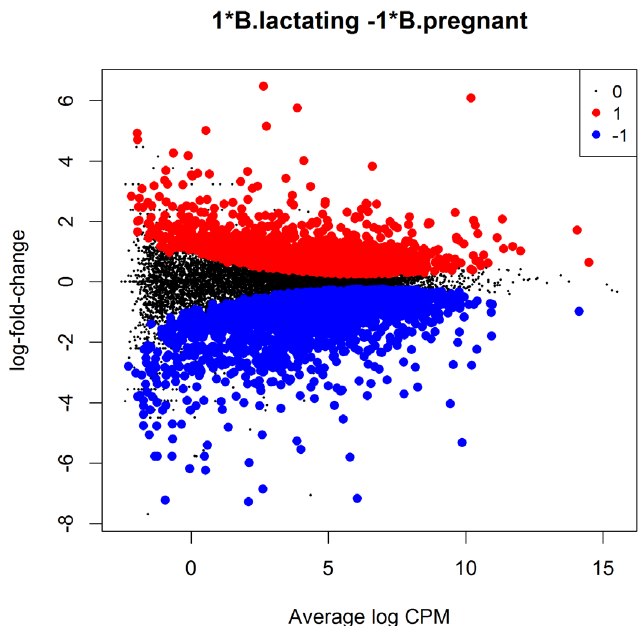
Figure 6. MD plot showing the log-fold change and average abundance of each gene. Significantly up and down DE genes are highlighted in red and blue,